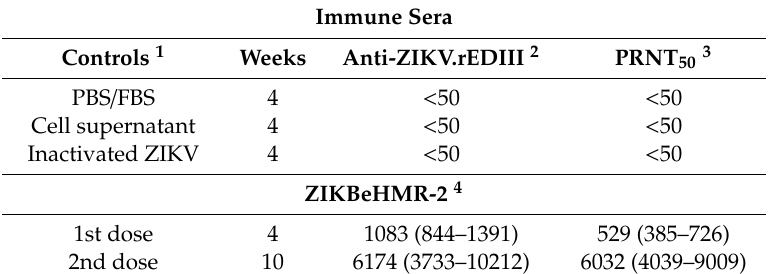
Table 1. Anti-ZIKV antibody response in BALB / c mice inoculated with ZIKBeHMR-2. Immune Sera Controls 1